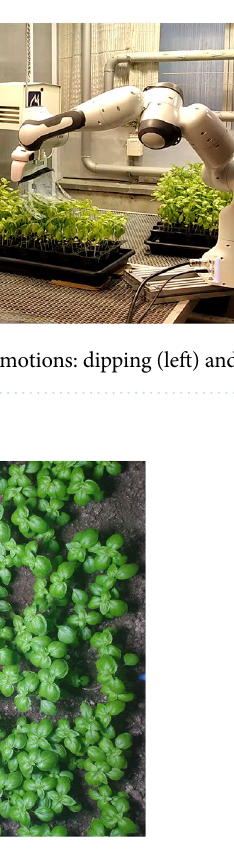
Figure 6. Lomas growing bed as observed in the fourth week from the start of the